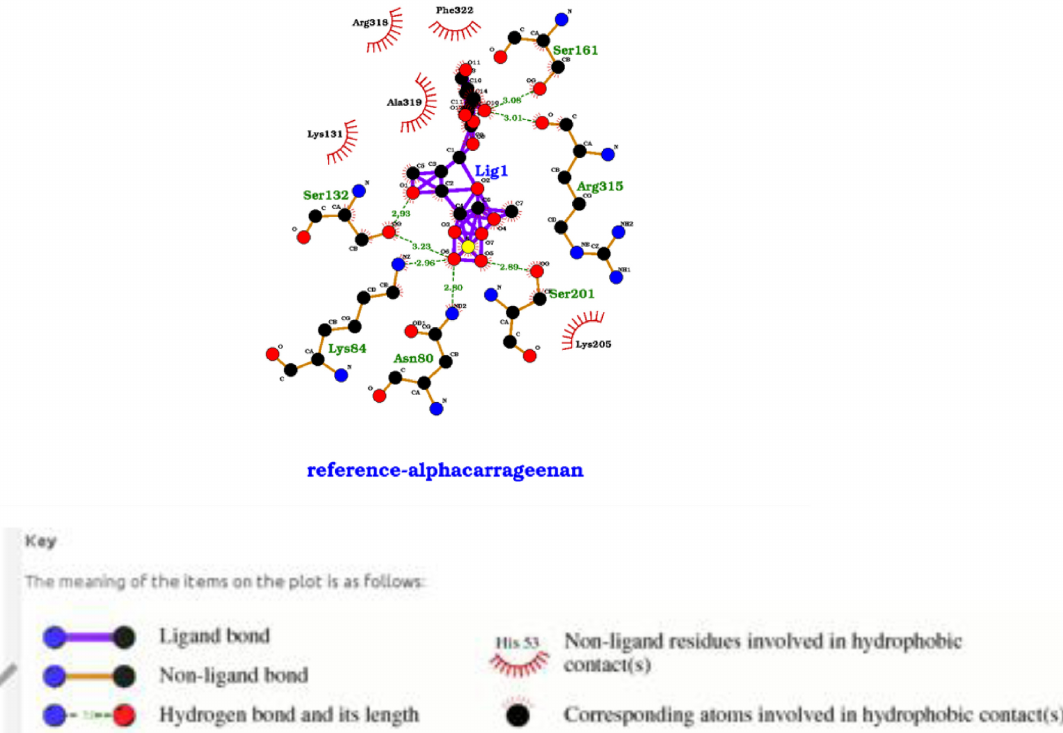
Figure 5. Ligplot showing hydrogen bonding, van der Waals forces and hydrophobic interactions between carrageenan and PHISTb/RLP1 reference protein. The compound interacts with S132, R315 and N80 amino acids located in the protein model binding site. This reveals the high affinity of interaction of this compound to the protein